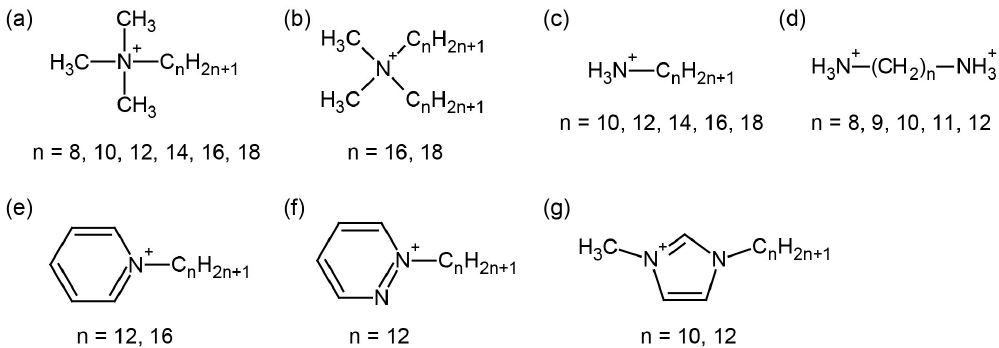
Figure 6. Several cationic surfactants employed to construct hybrid surfactant single crystals with discrete inorganic anions: ( a ) alkyltrimethylammonium; ( b ) dialkyldimethylammonium; ( c ) alkylammonium; ( d ) alkyldiammonium; ( e ) alkylpyridinium; ( f ) alkylpyridazinium; ( g ) 1-alkyl-3- methylimidazolium.